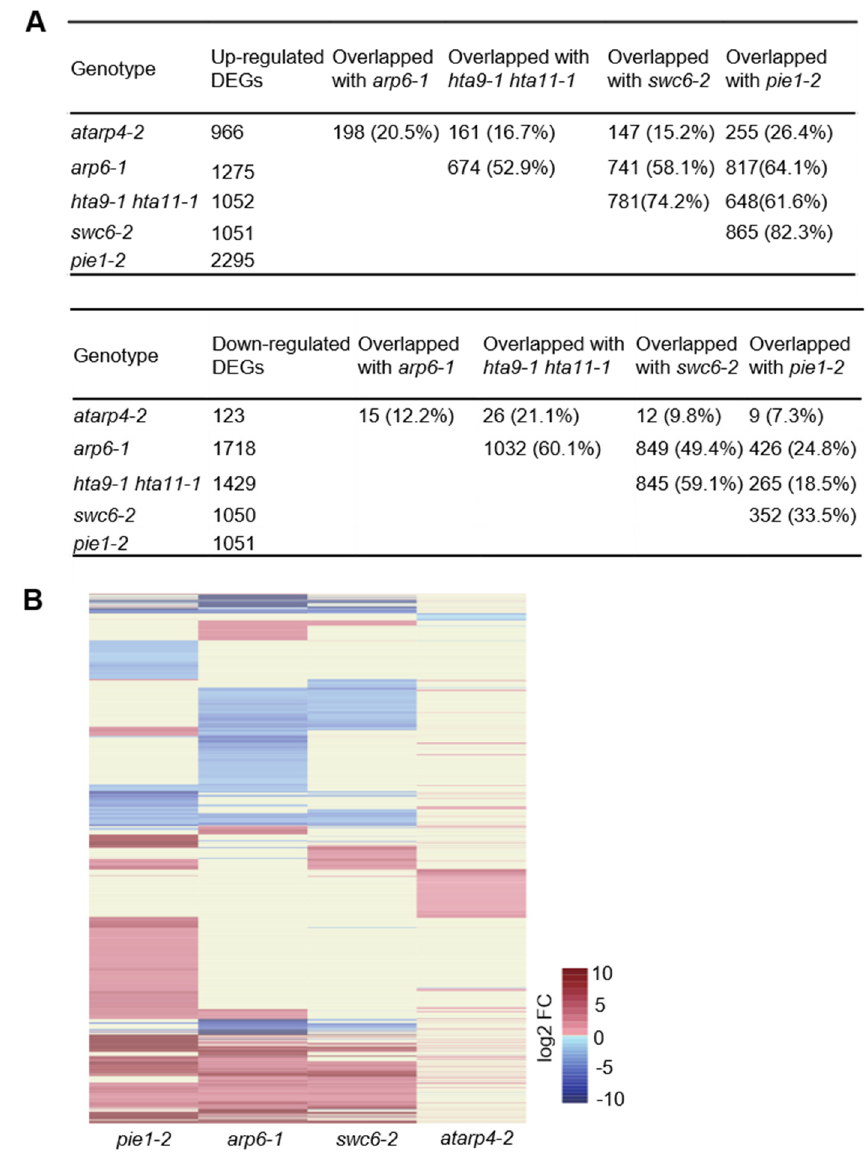
Figure 5. The differential transcriptomic responses between atarp4-2 plants and swr1 -related mu- tants. ( A ) Number of up-regulated and down-regulated DEGs identified in atarp4-2 , arp6-1 , hta9-1 hta11-1 , swc6-2 , and pie1-2 mutants, and the respective overlaps of DEGs (fold change ≥ 2 or fold change ≤ 0.5). ( B ) Fold change (FC)-based heatmaps of pie1-2 , arp6-1 , swc6-2 , and atarp4-2 mutants. The mRNA-seq raw data for pie1-2 , arp6-1 , swc6-2 and hta9-1 hta11-1 were downloaded from a pre- vious study, Adapted with permission from ref. [3]. 2016 Elsevier.